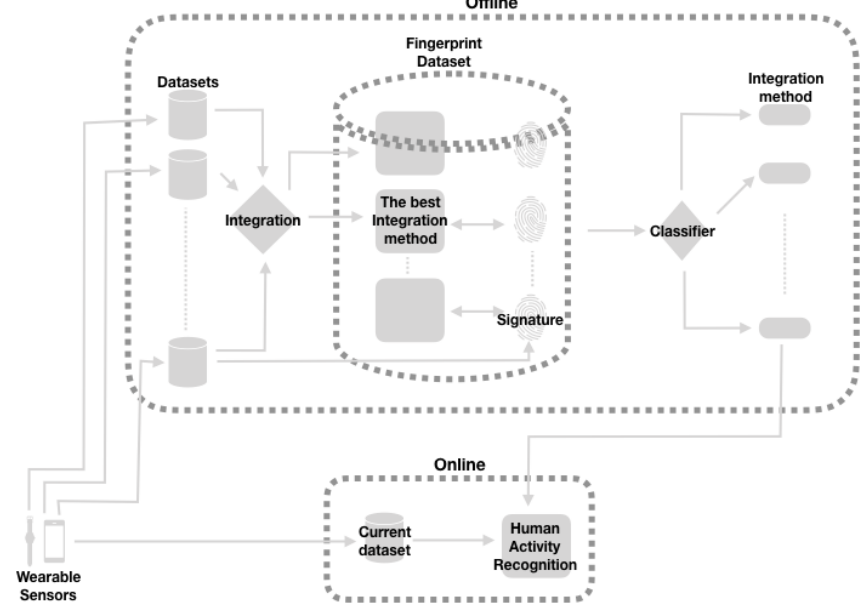
Figure 1. Architecture of a virtual